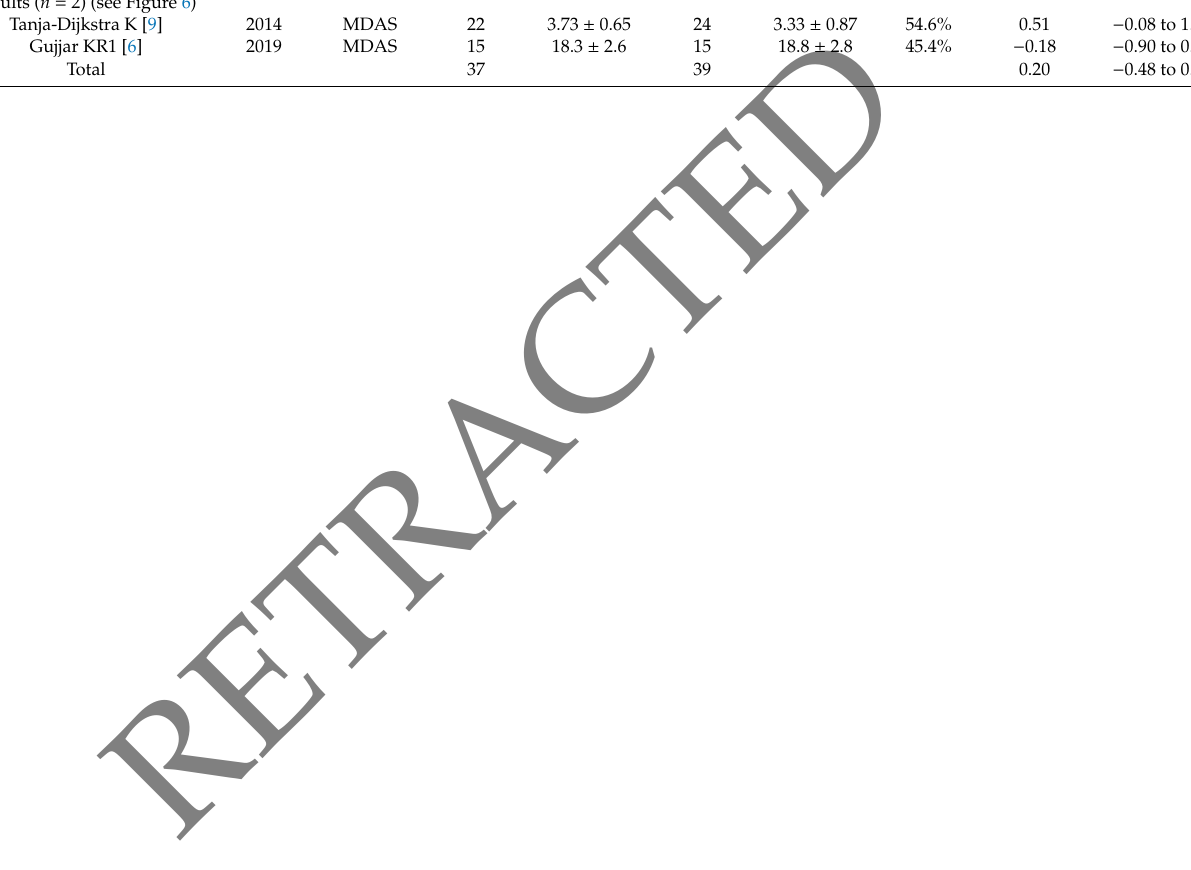
Adults ( n = 2) (see Figure 6) Tanja-Dijkstra K